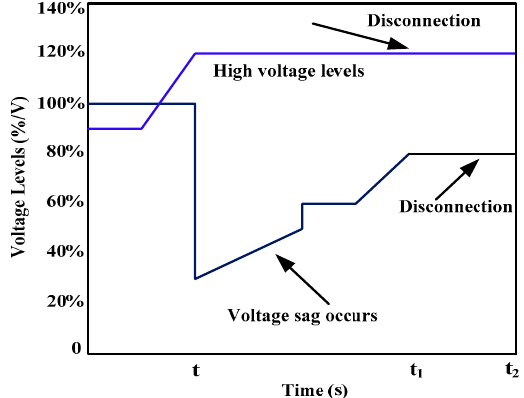
Figure 20. Voltage requisites during the low-voltage ride through (LVRT) and high-voltage ride through HVRT at PCC [38].